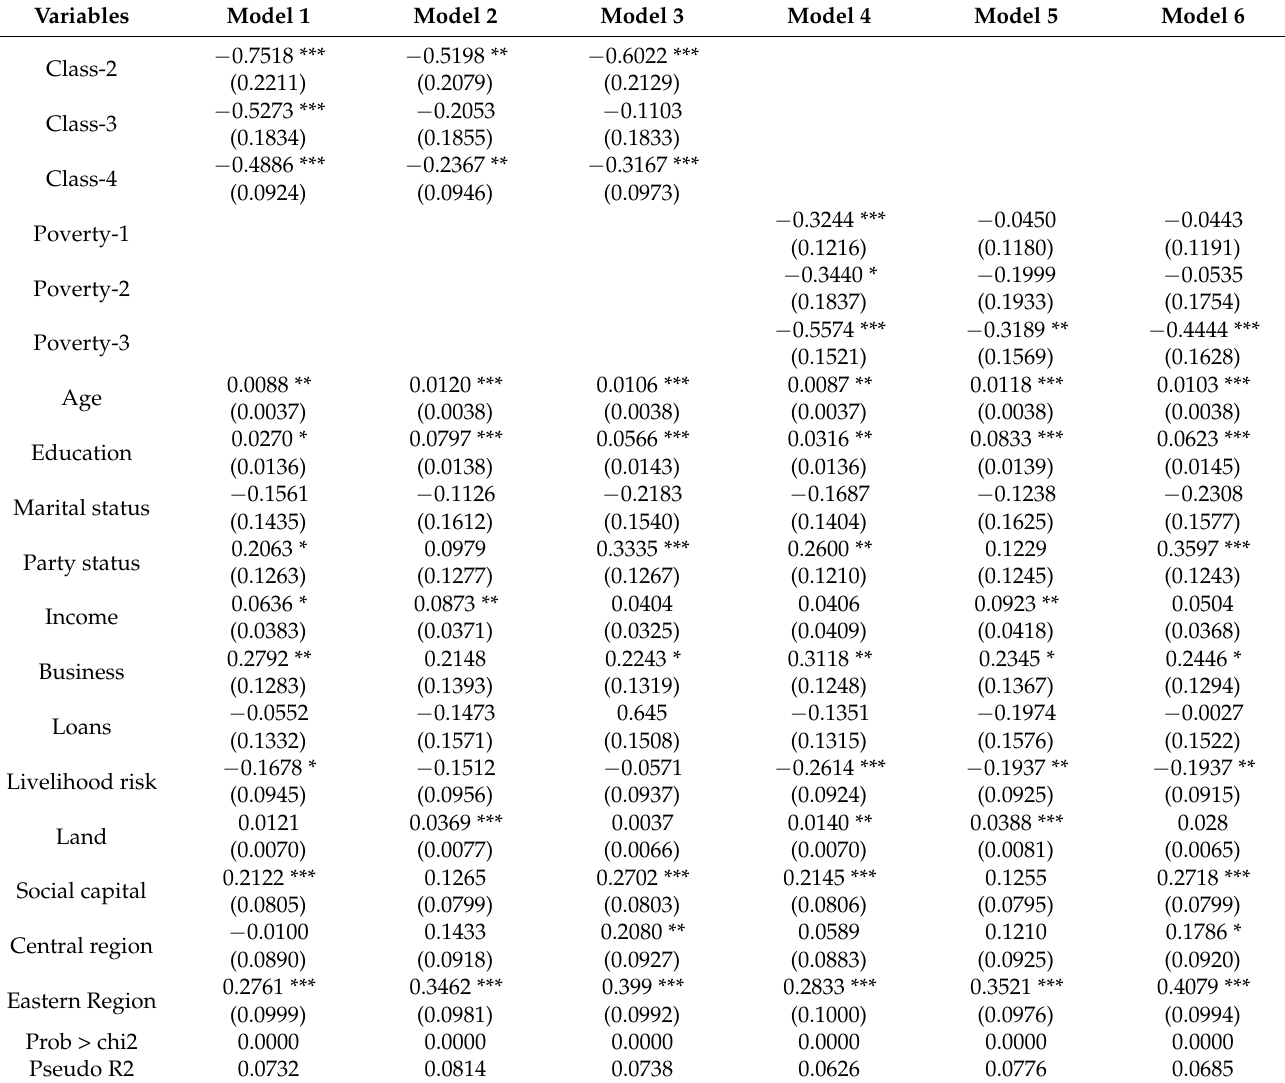
Table 7. Results of ordered probit regression of sense of